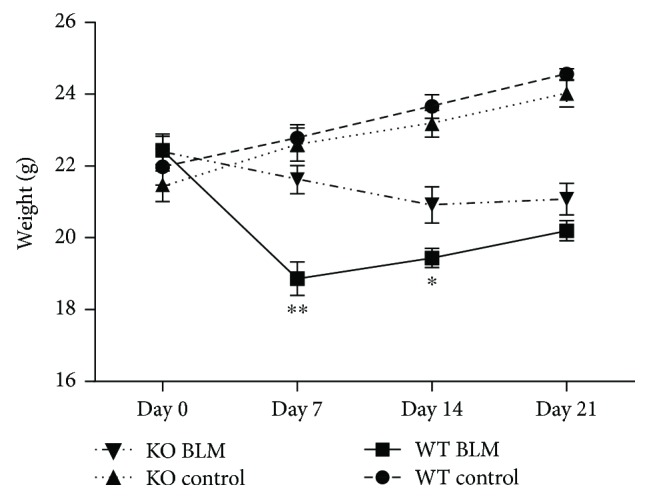
Effect of 5-HT on weight loss induced by bleomycin in mice. Intratracheal instillation of bleomycin (BLM) hydrochloride was performed to induce pulmonary fibrosis in wild-type C57BL/6 (WT) and TPH1 knockout (KO) mice. The changes in body weight of mice from the WT and KO control, WT BLM, and KO BLM groups were examined over the 21-day study period. All data were expressed as mean ± SD, n = 6. ∗P < 0.05 and ∗∗P < 0.01 versus the WT BLM group.